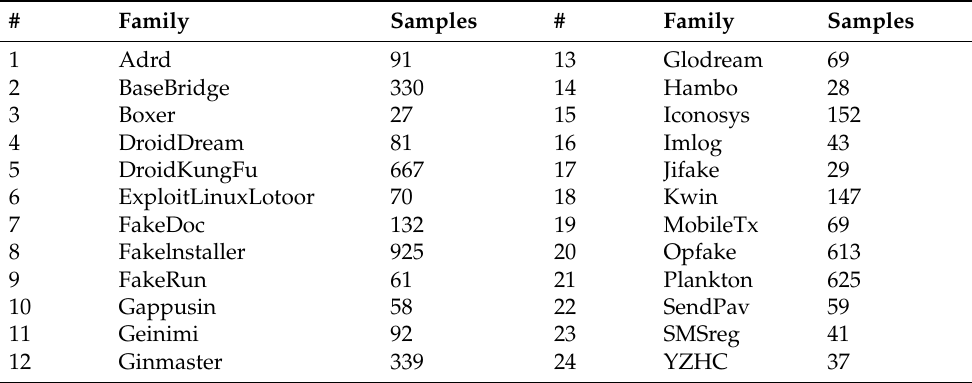
Table 2. Considered malware families from the Drebin